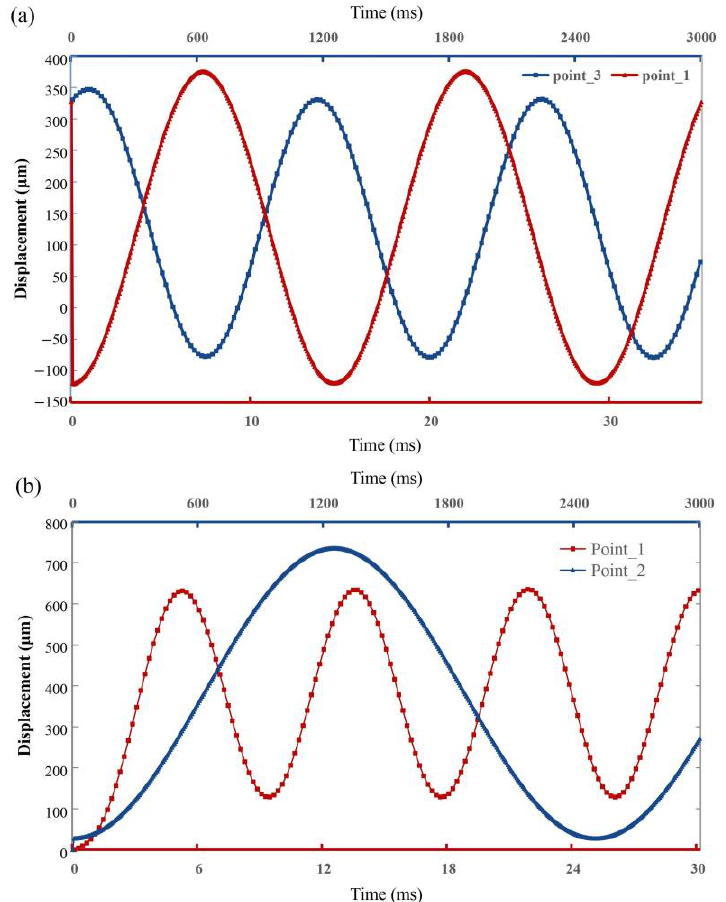
Figure 9. The frequencies of the fast shaft and the slow shaft. ( a ) “ O ” type. ( b ) “ Z ” type.